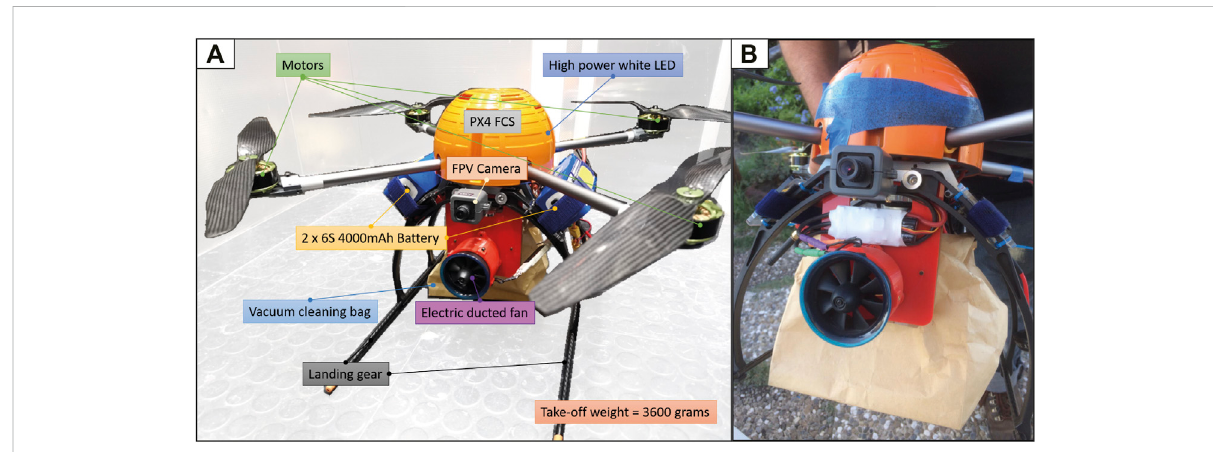
FIGURE 2 (A) Photograph of the Remotely Piloted Aircraft System (RPAS) used during fi eld deployment. The red 3D printed housing seen in the middle of the multirotor houses an electric ducted fan system used to pull air and ash into the sample bag. Acronyms: LED — Light-Emitting Diode; FPV —